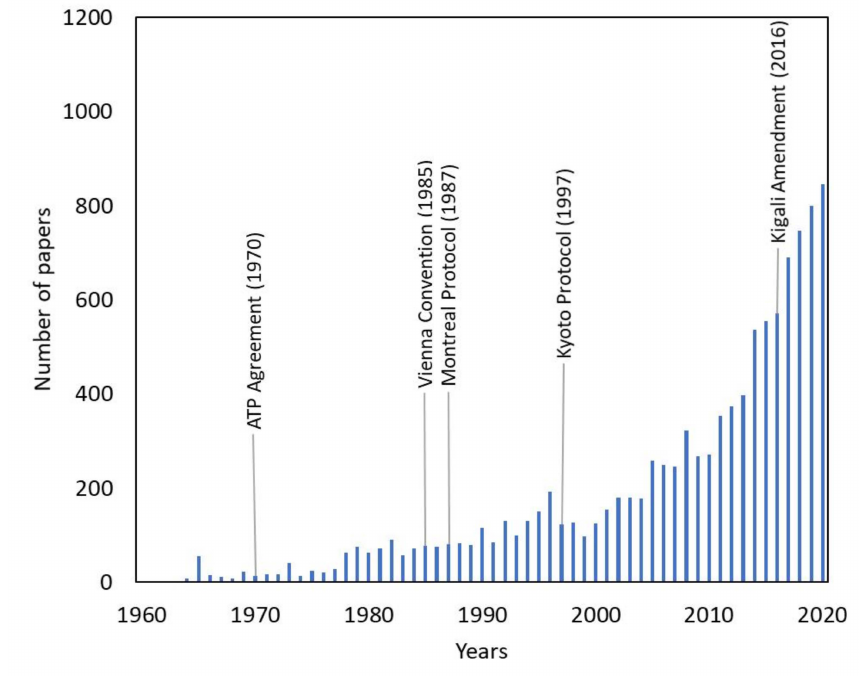
Figure 1. Number of scientific papers about refrigerated transport in last decades (source: ScienceDi- rect: data used for number of publications regarding refrigerated transport since